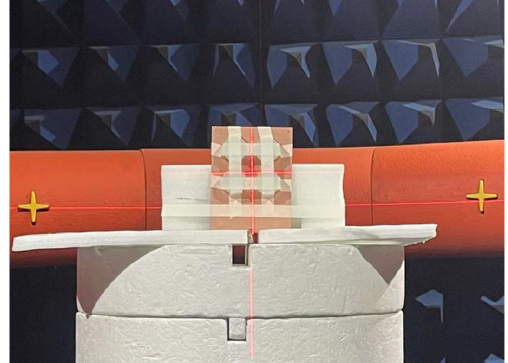
Figure 6. Test environment of the prototype DRA array.